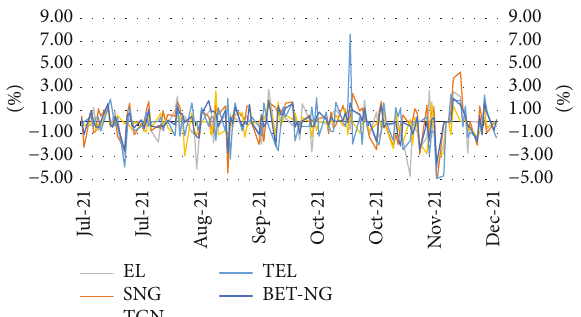
Figure 4: Evolution of BET-NG index and of the companies listed